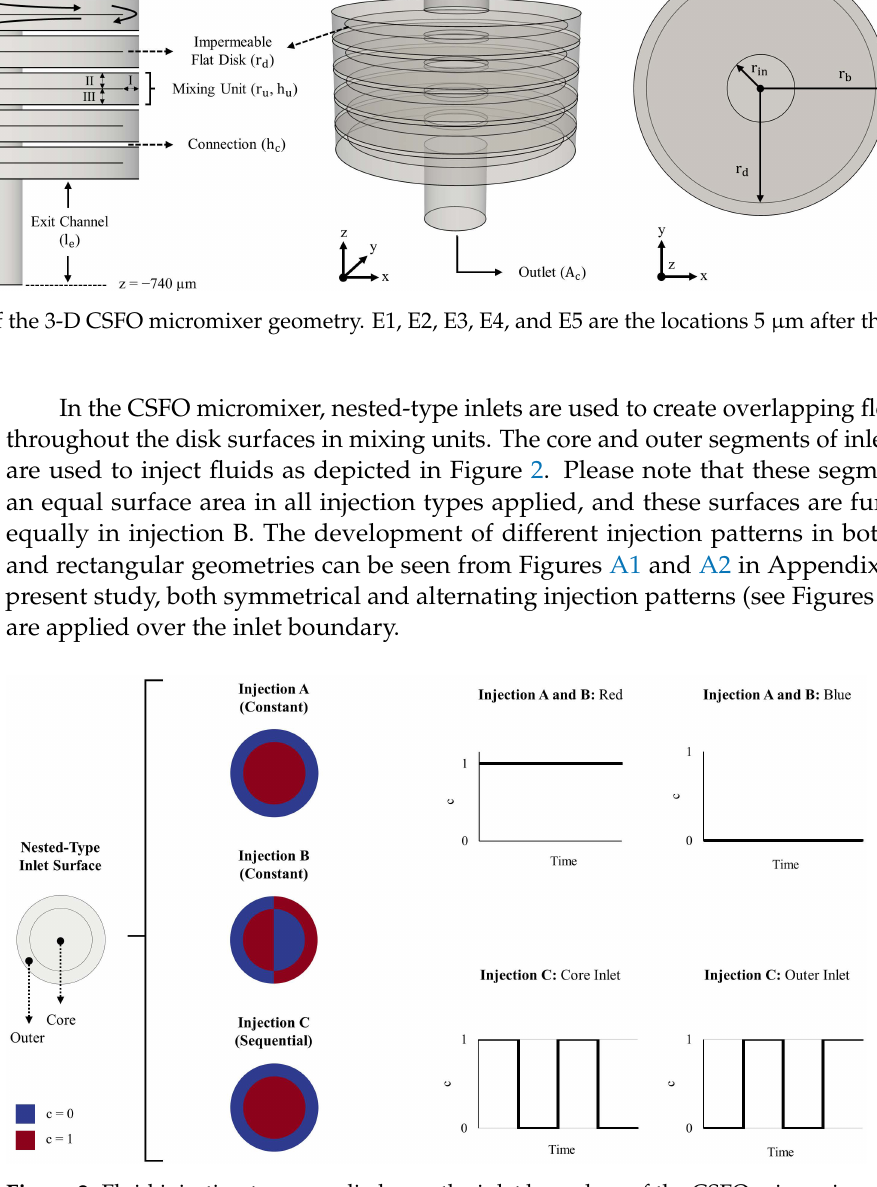
Figure 2. Fluid injection types applied over the inlet boundary of the CSFO micromixer